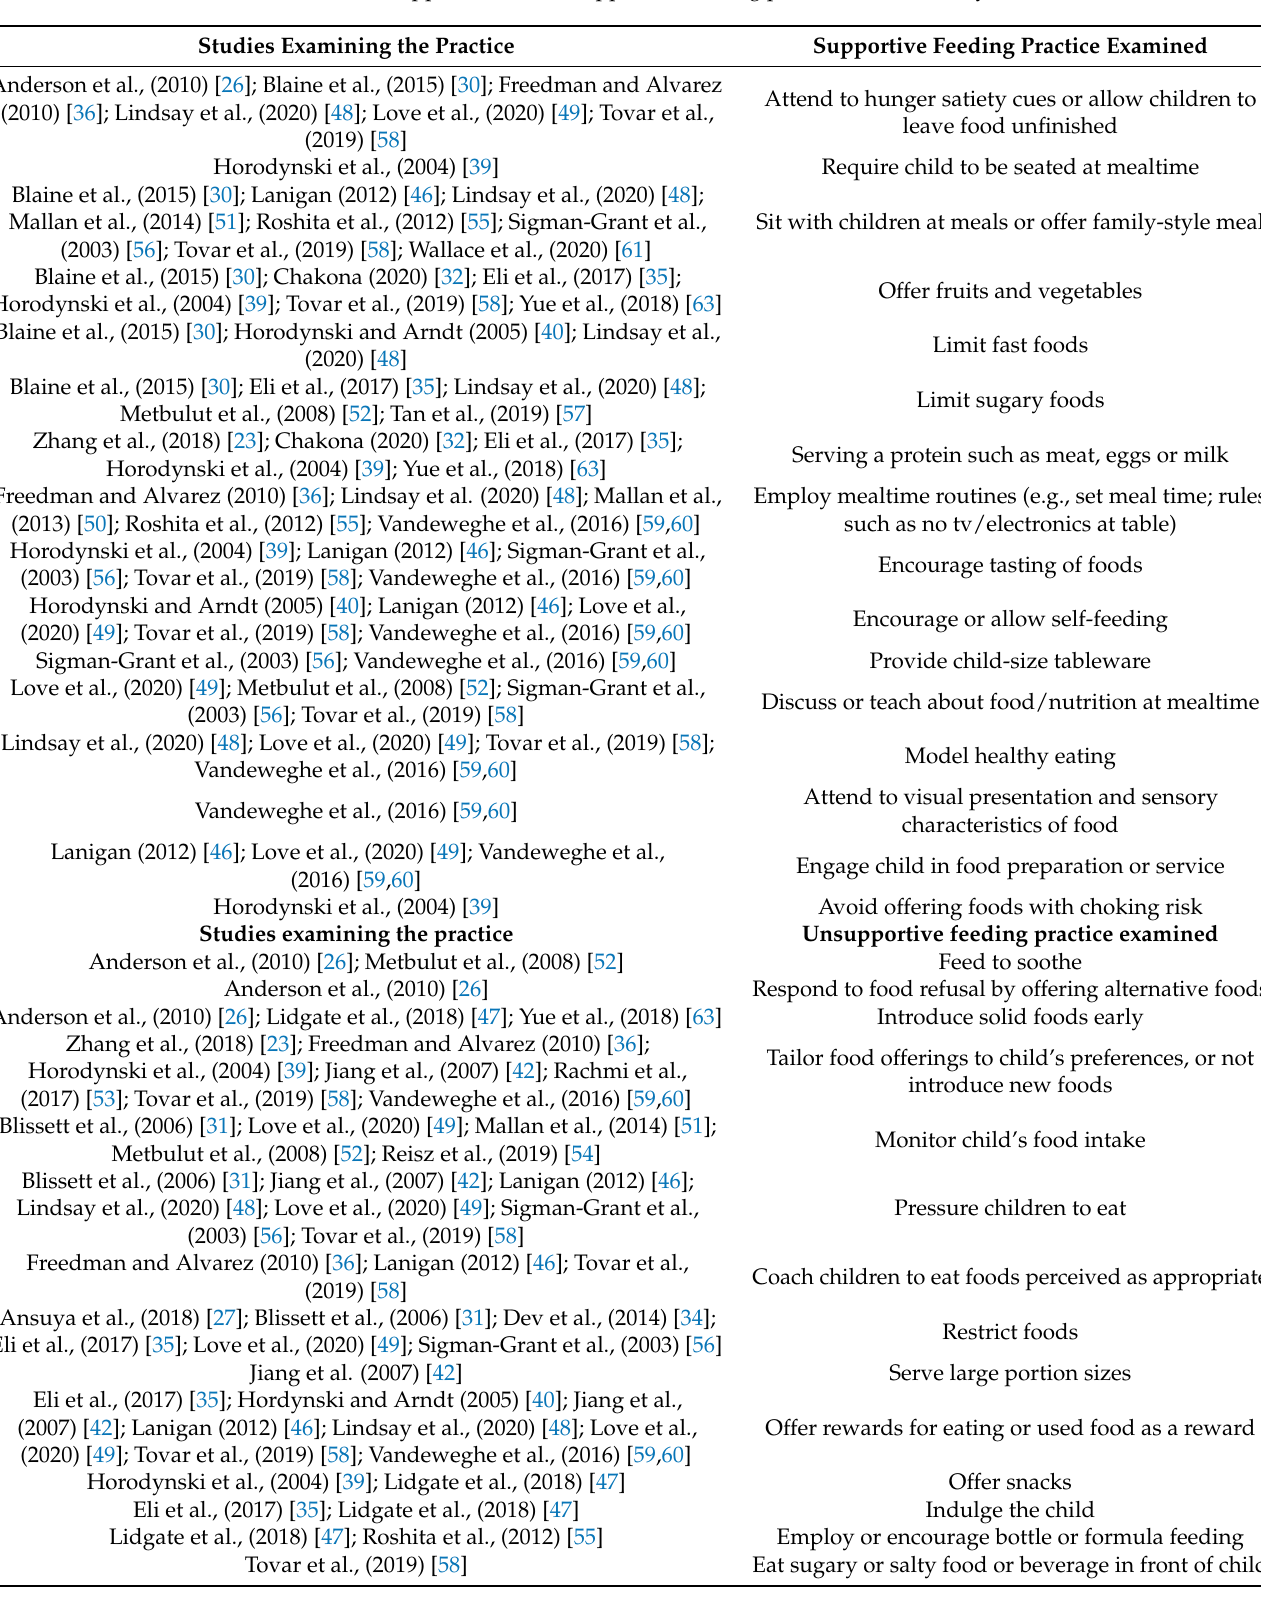
Table 2. Supportive and unsupportive feeding practices examined by studies in the